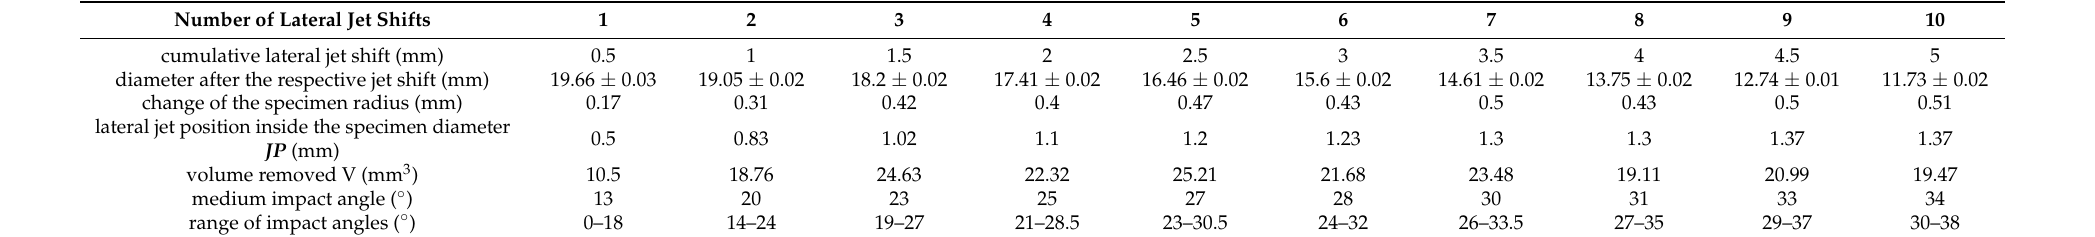
Table 8. Experimental results with the lateral jet shift 0.5 mm.